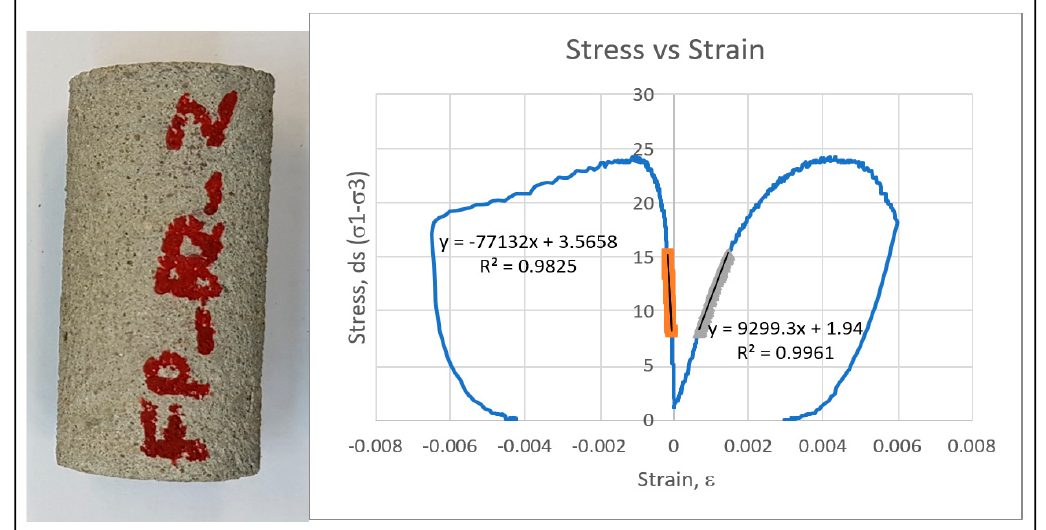
Figure 5. Uniaxial compressive strength test results for saturated samples. Table 1. Uniaxial compressive strength and Young’s modulus comparison of dry and saturated samples.